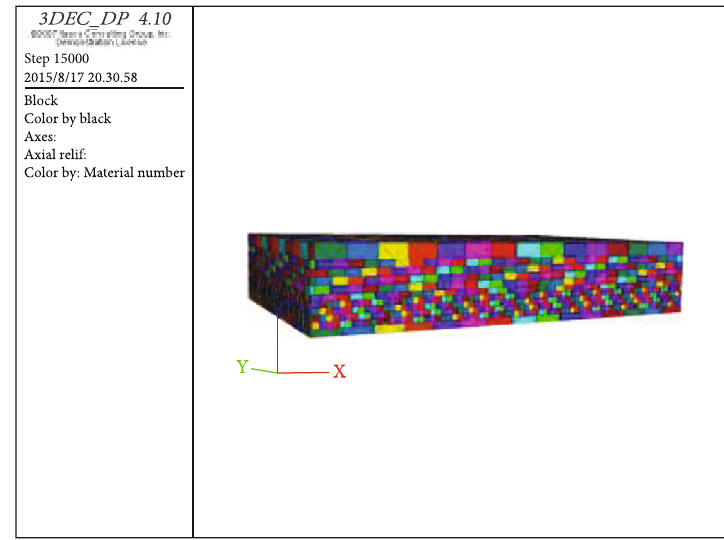
Figure 6: Three-dimensional calculation model of rock mass deformation of mining. Table 1: Physical and mechanical parameters of surrounding rock properties.